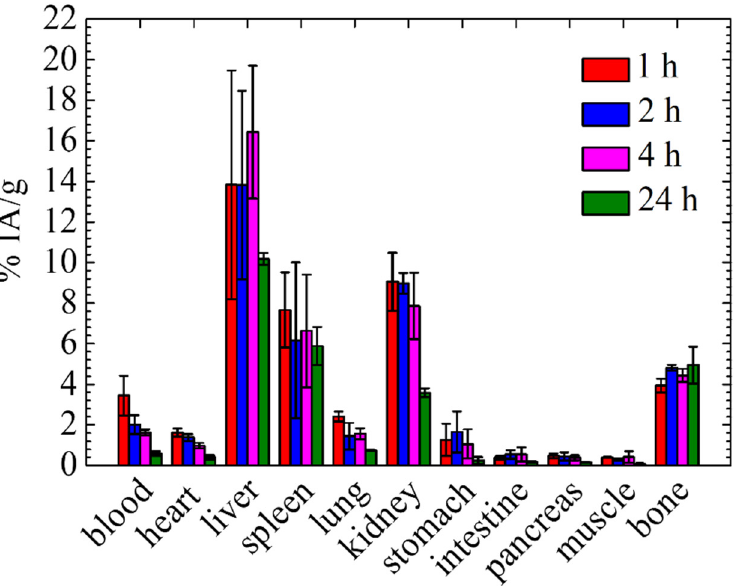
Figure 2. The accumulation of the [ 99m Tc]Tc-DPD-Fe 3 O 4 DMCA in the organs of normal Swiss mice, expressed as percentage injected activity per gram of tissue (% IA/g) at 1, 2, 4 and 24 h post injection (p.i.). For each time point, three mice were studied; thus, the results are expressed as the MV ± SD.